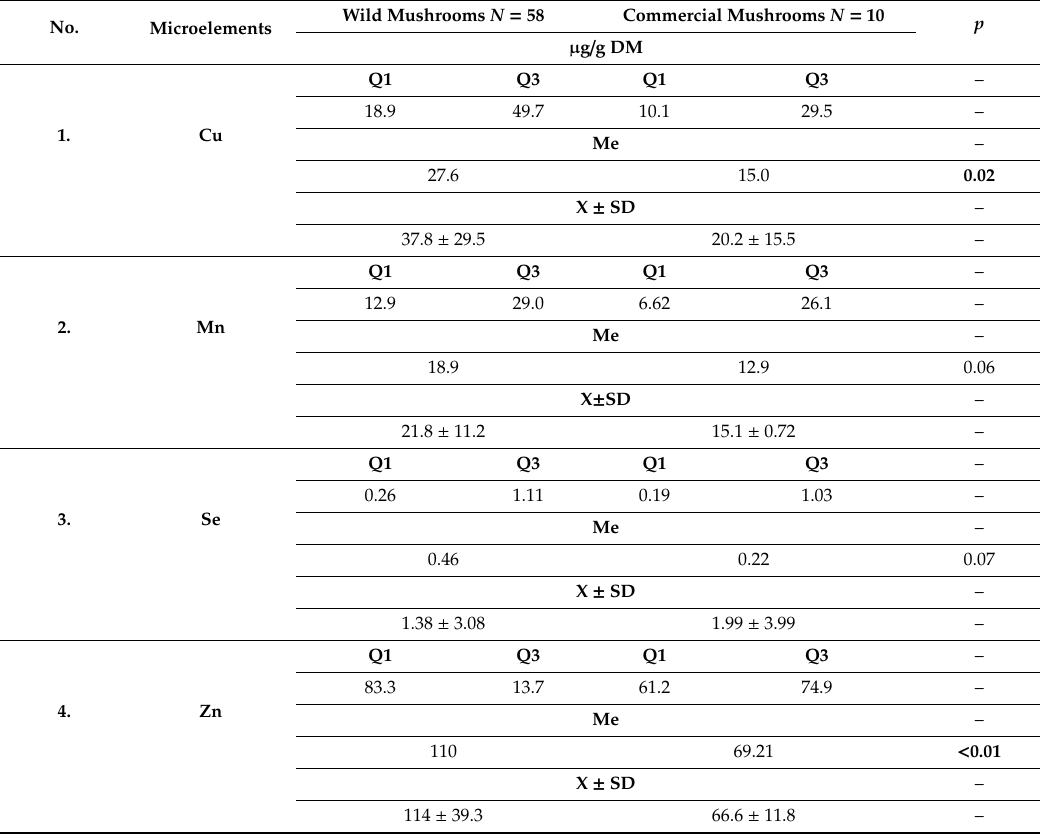
Table 5. Cu, Mn, Se, and Zn content in the studied mushrooms depending on the growth